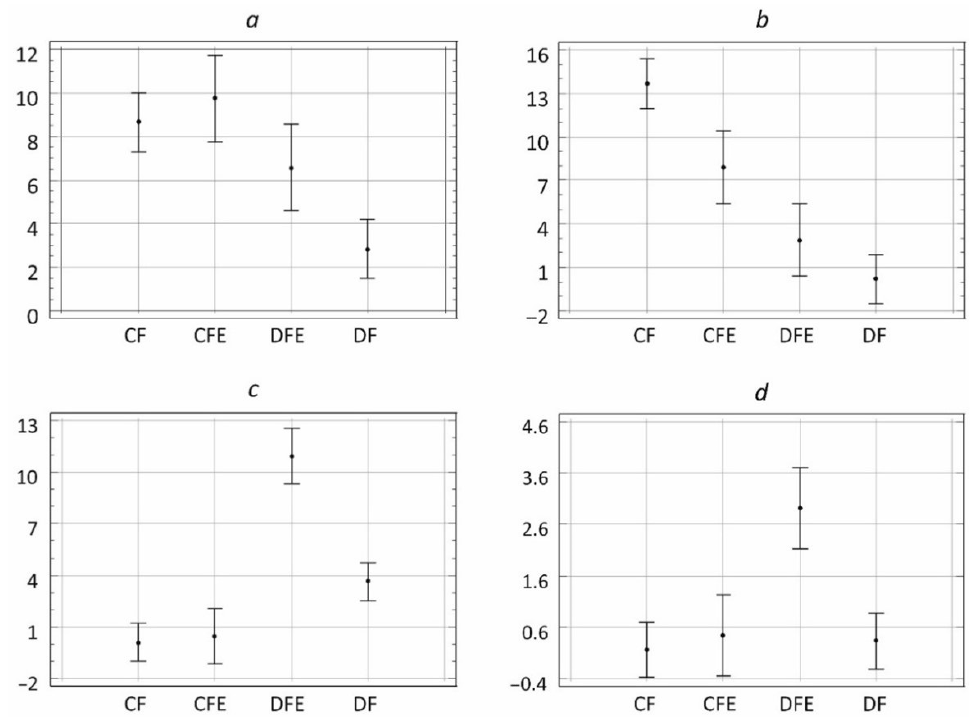
Figure 7. Average percentage covers of moss layer dominants in the ecotone complex. ( a )